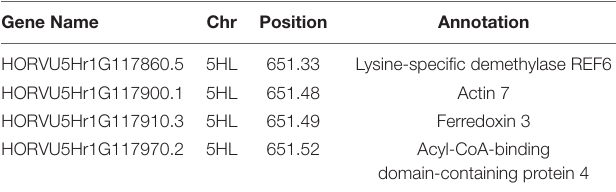
TABLE 1 | Candidate genes identified in relation to salinity tolerance in regards to biomass growth, with the chromosome and position on the physical map listed.